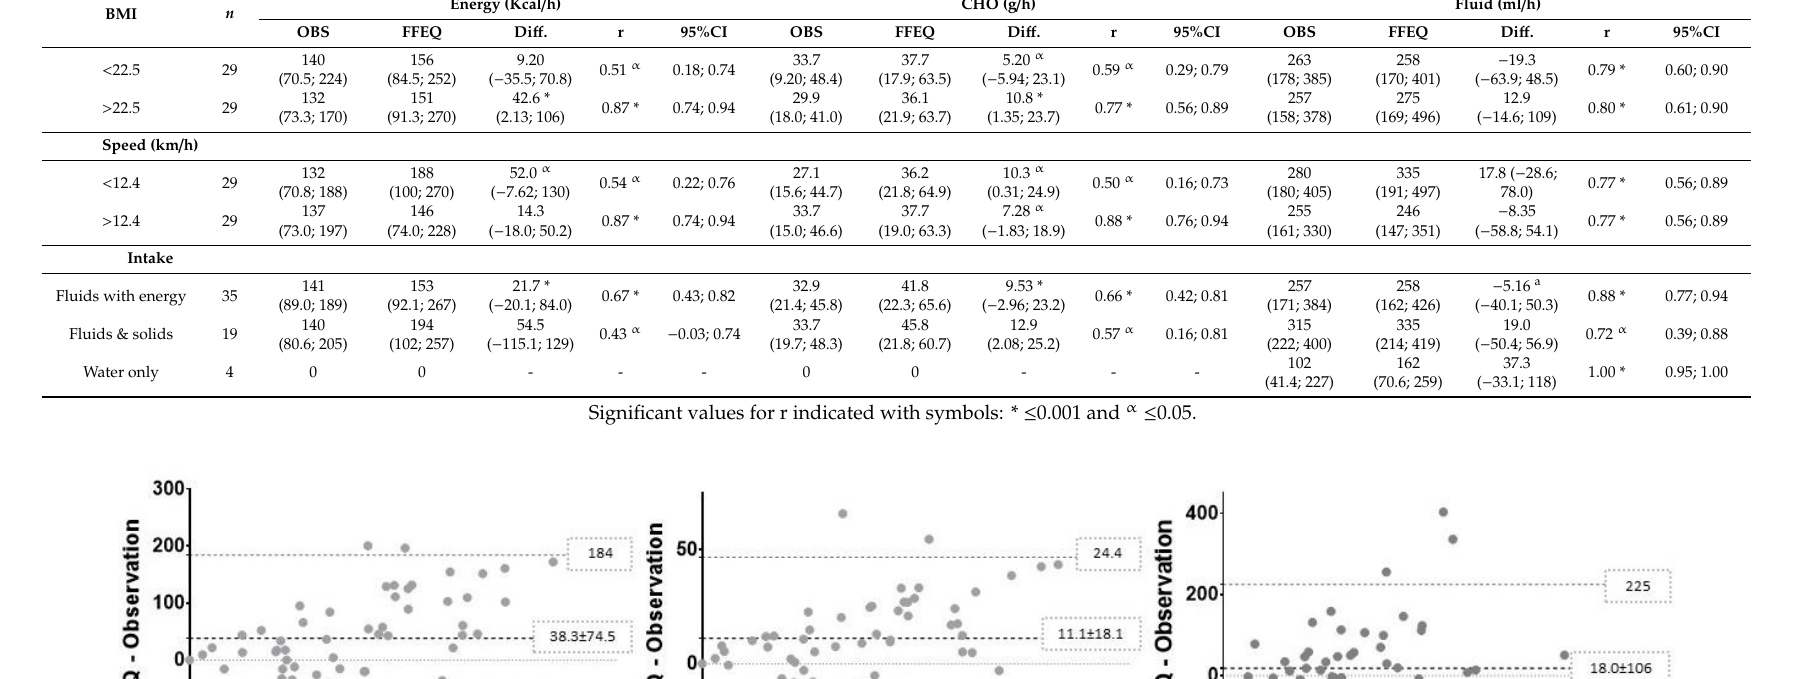
Table 4. Median and IQR, difference, and correlations with a 95% CI between FFEQ-measured and observed intake for energy, carbohydrate (CHO), and fluid (FLU) per hour by BMI, speed, and intake.